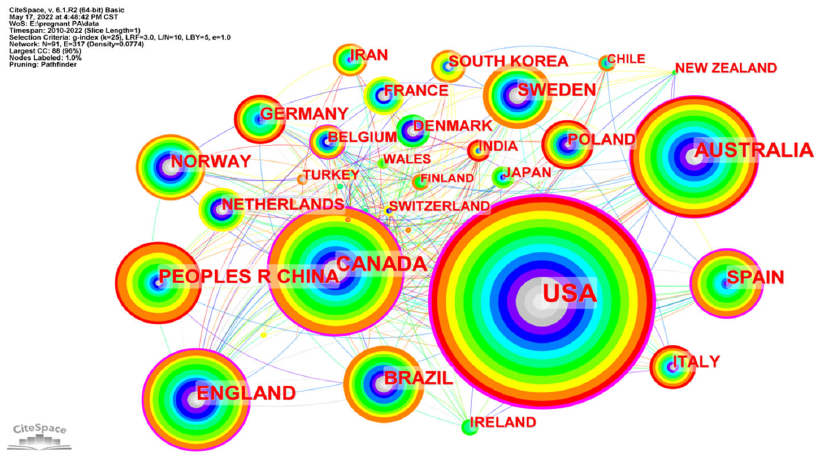
Figure 4. Co-occurrence map of countries researching physical activity during pregnancy.